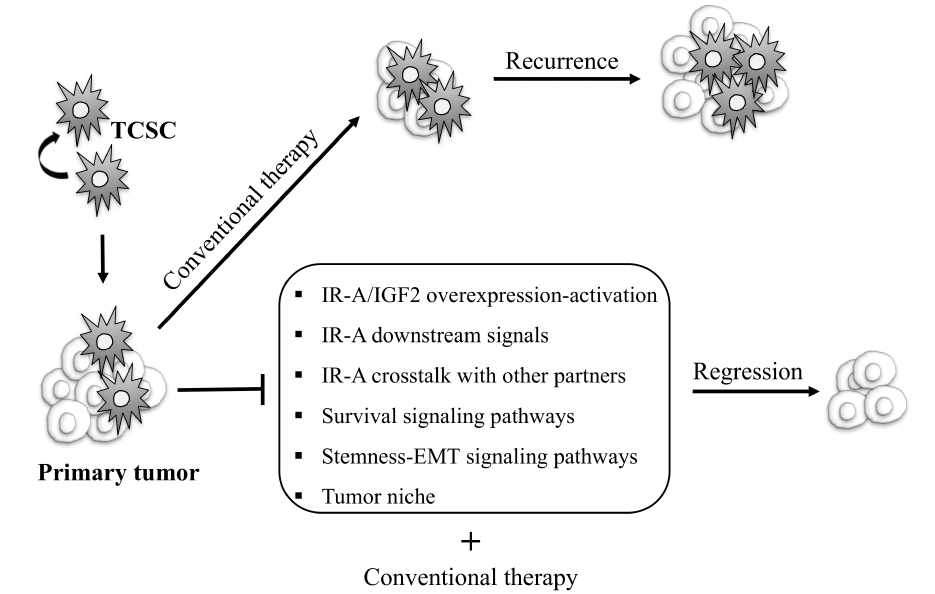
Figure 2. Schematic representation of possible therapeutic strategies targeting thyroid cancer initiating progenitor cells to eradicate TC. Thyroid cancer stem cells (TCSC) are considered to be responsible of TC initiation, progression, therapeutic resistance, and recurrence. Conventional therapy fails to destroy these cells, contributing to tumor relapse and metastases. TCSC-focused therapies may include strategies aiming to inhibit IR-A/IGF2 overexpression and activation, IR-A-mediated mitogenic signals, the crosstalk between IR-A and other molecular partners, signaling pathways regulating survival, stemness, EMT programs, and the tumor niche. This strategy combined with conventional therapy could allow us to eradicate tumor cells and obtain complete